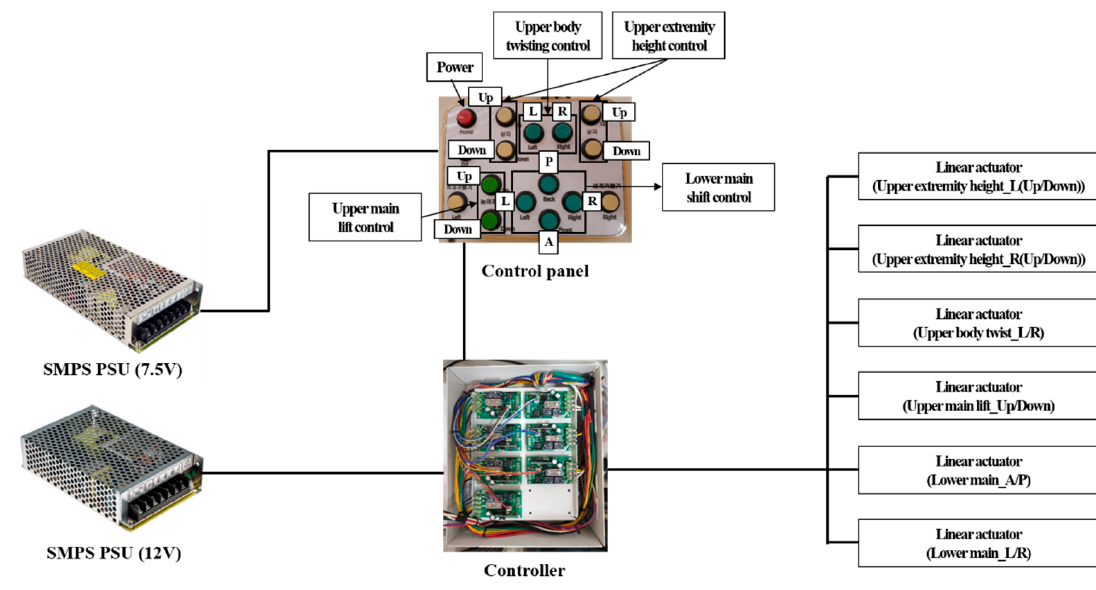
Figure 2. Overview of the exercise rehabilitation device.